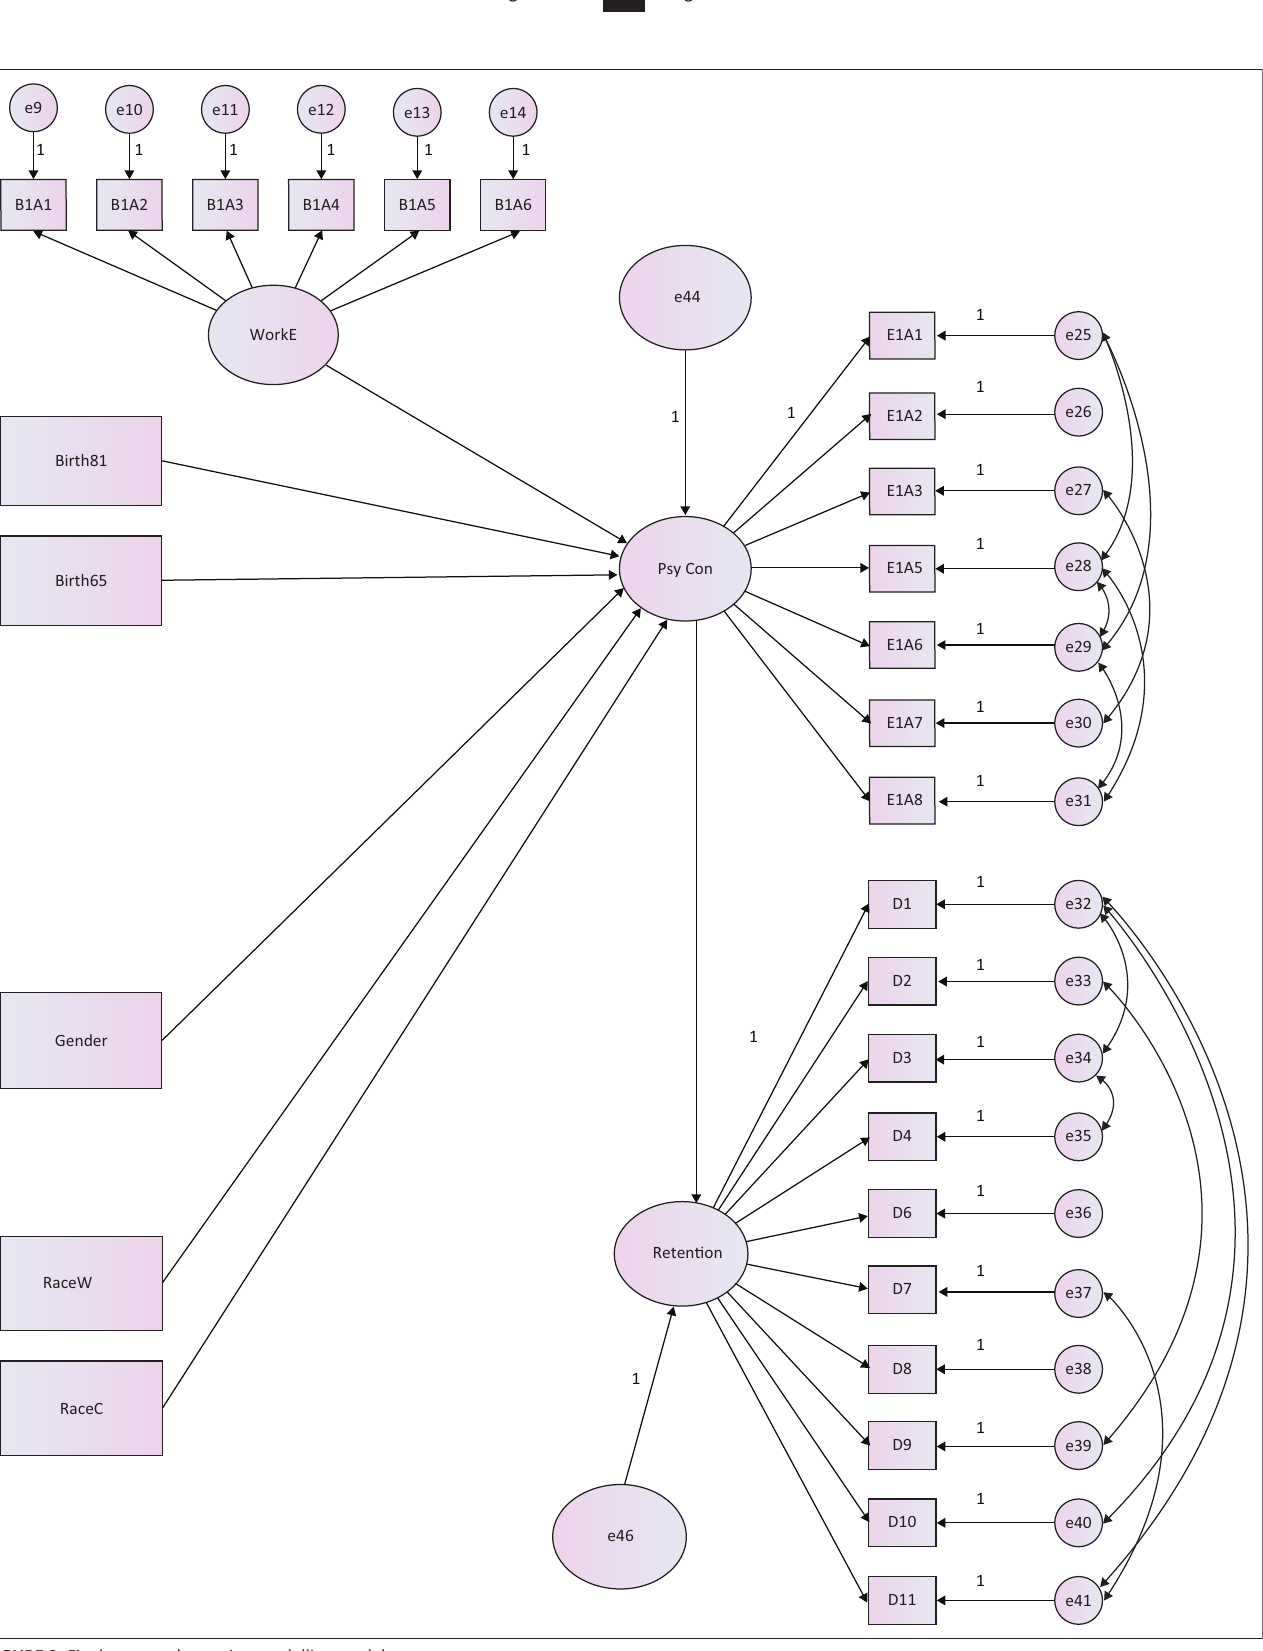
FIGURE 2: Final structural equation modelling